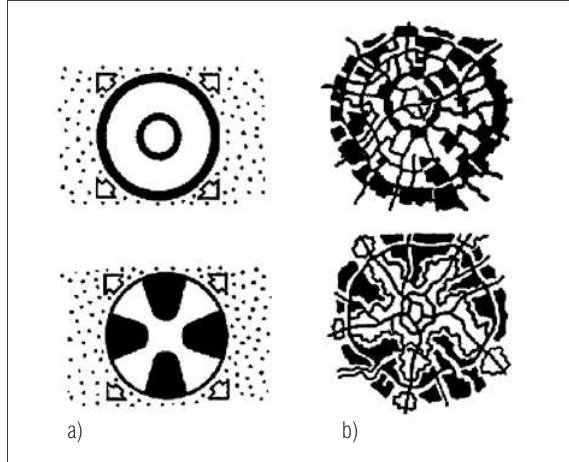
Fig 2. Circular (a) and wedge-shaped (b) systems